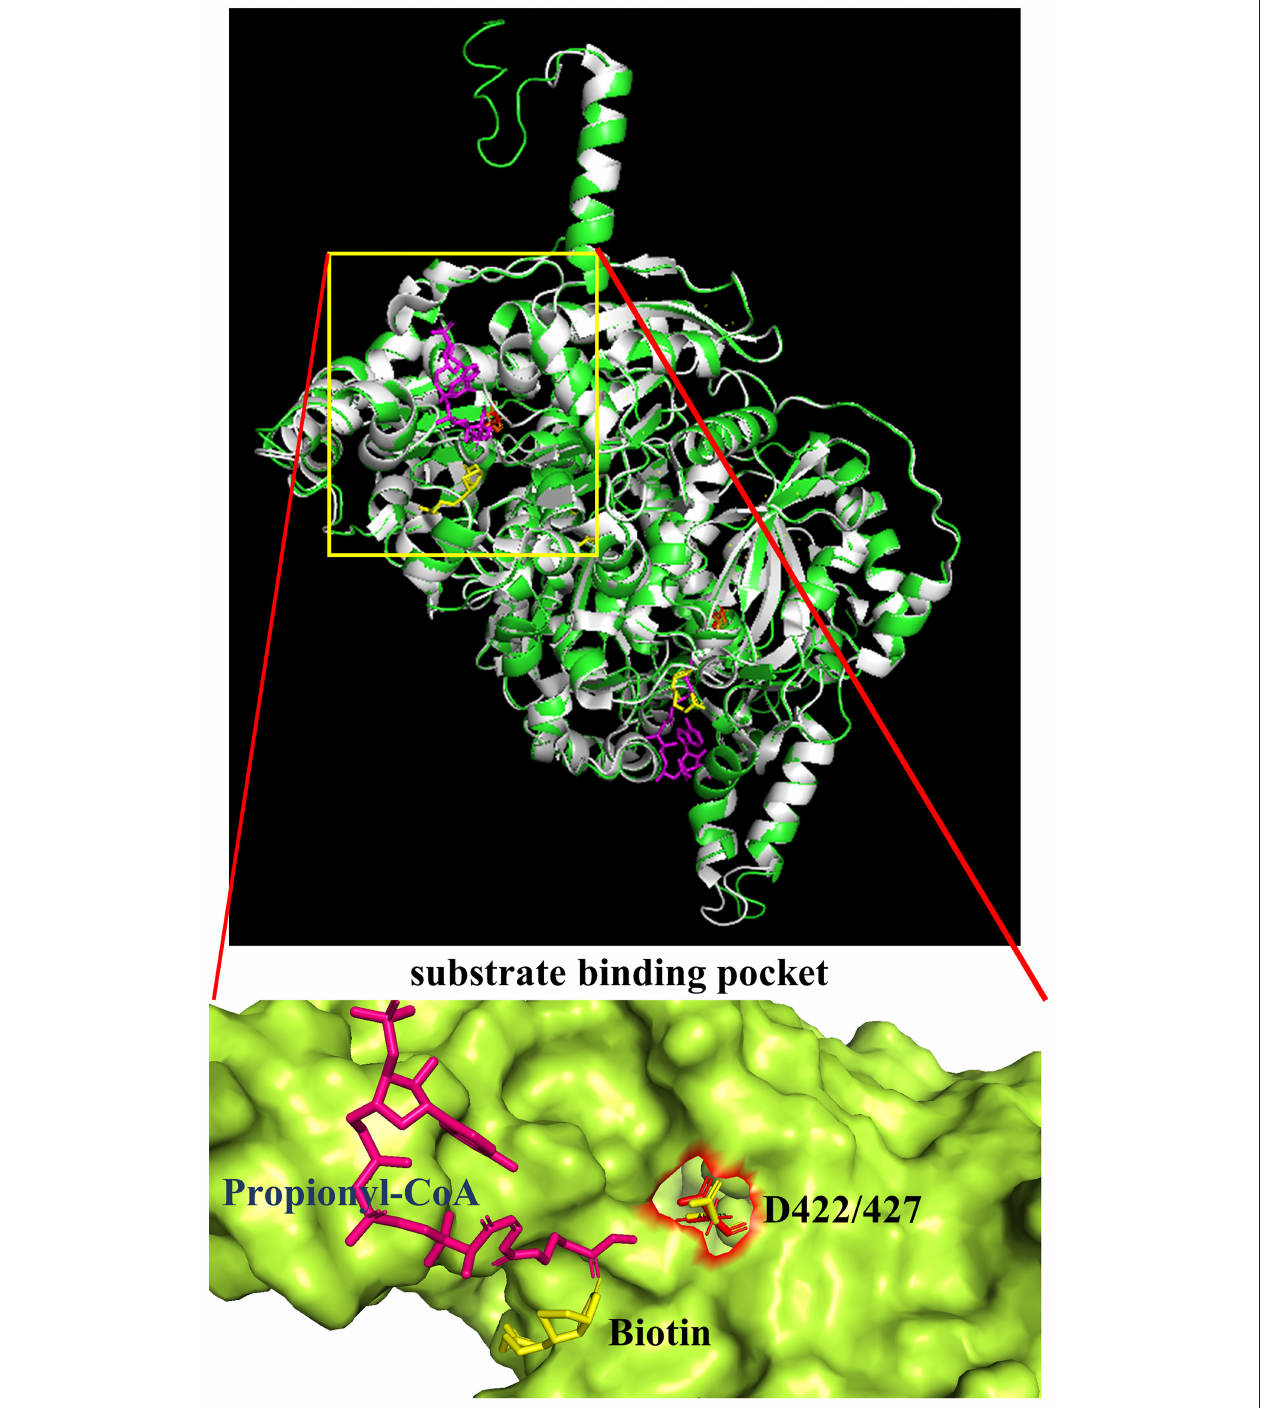
FIGURE 5 | Superimposition of the TfAcCCB computational tertiary structure model developed by using I-TASSER (green) and the ScPccB experimentally determined tertiary structure (PDB: 1XNY) (gray). RMSD of the aligned atoms between the two structures is 0.3 Å (2,830 atoms aligned out of 3,797, after rejecting the 527 outlier atoms). The expanded view of the substrate binding site identifies the relative atomic positions of propionyl-CoA, biotin and D427 as determined in the PDB:1XNY structure.